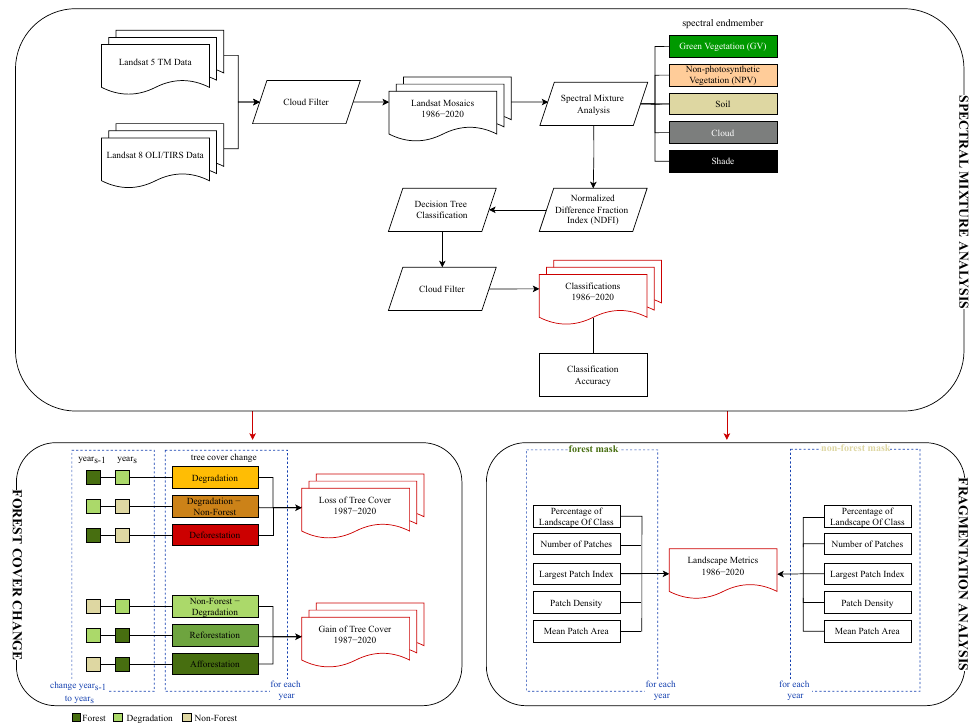
Figure 3. Schematic